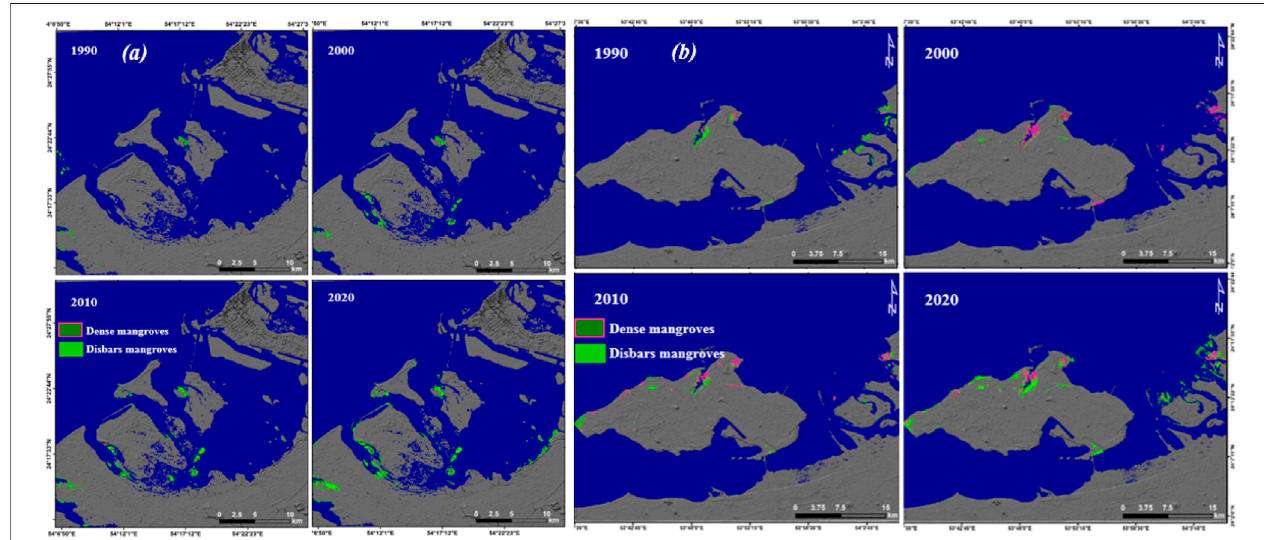
FIGURE 11 | Annual rate of Abu Dhabi mangrove growth (classes and total area in km 2 ) during the period from 1990 to 2020.